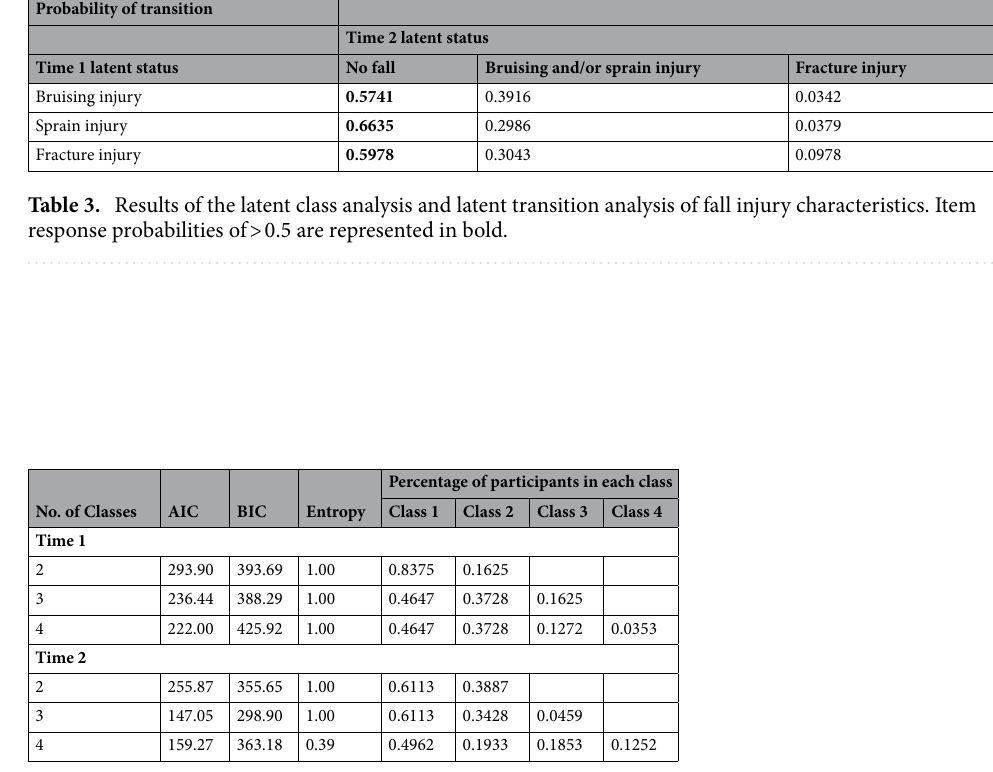
Table 4. Model fit and percentage of participants in each latent class. AIC, akaike information criterion; BIC, Bayesian information